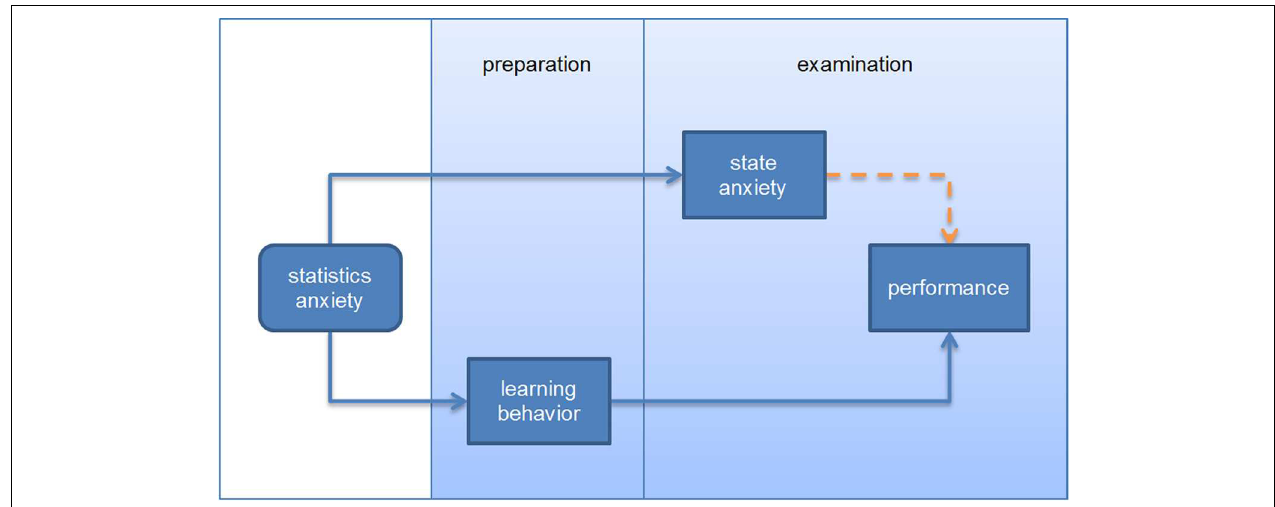
FIGURE 1 | The two-fold effect of statistics anxiety on